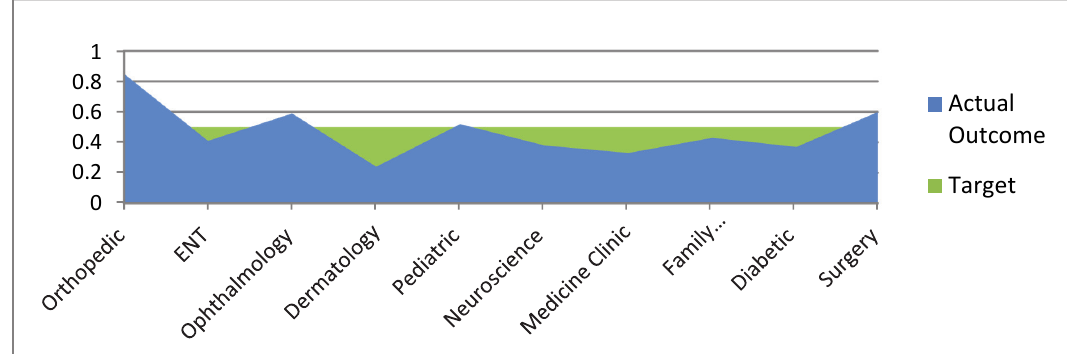
Fig. 2. All clinics' outcomes as calculated by the FTE system